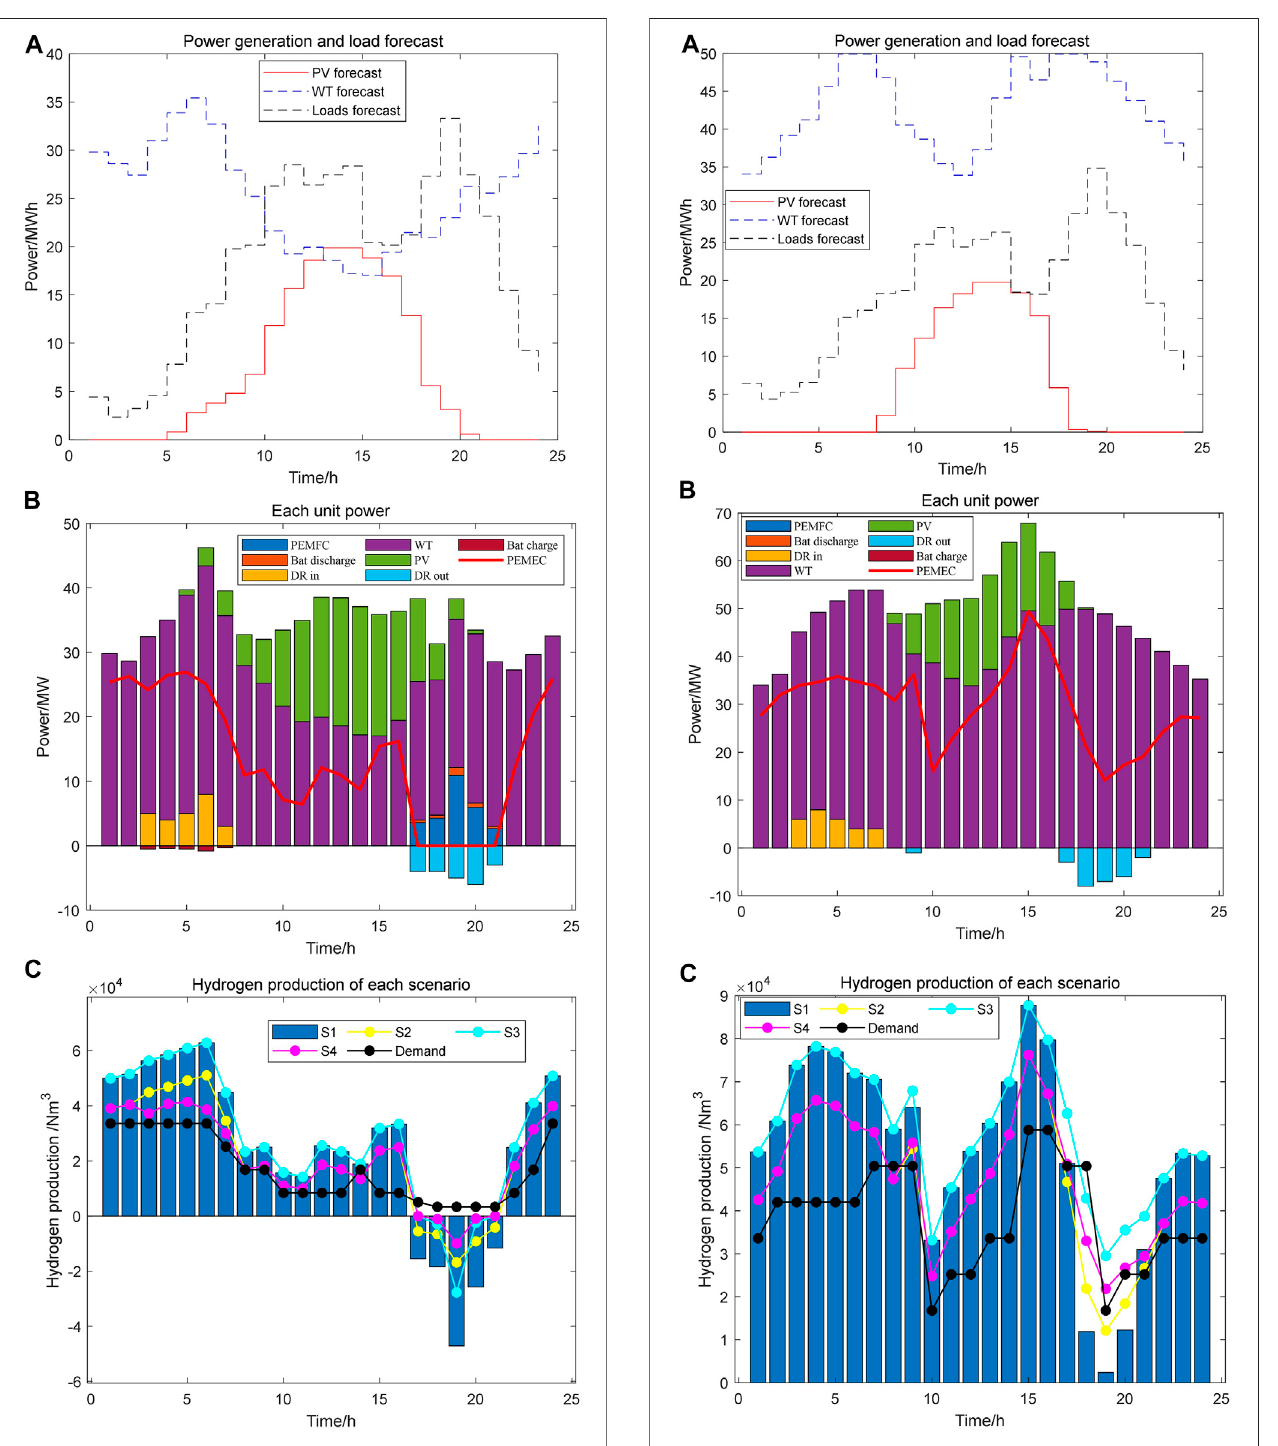
FIGURE 8 | (A) Day-ahead forecast results of a typical summer day, (B) each unit power of a typical summer day, (C) hydrogen production and hydrogen demand of a typical summer day.